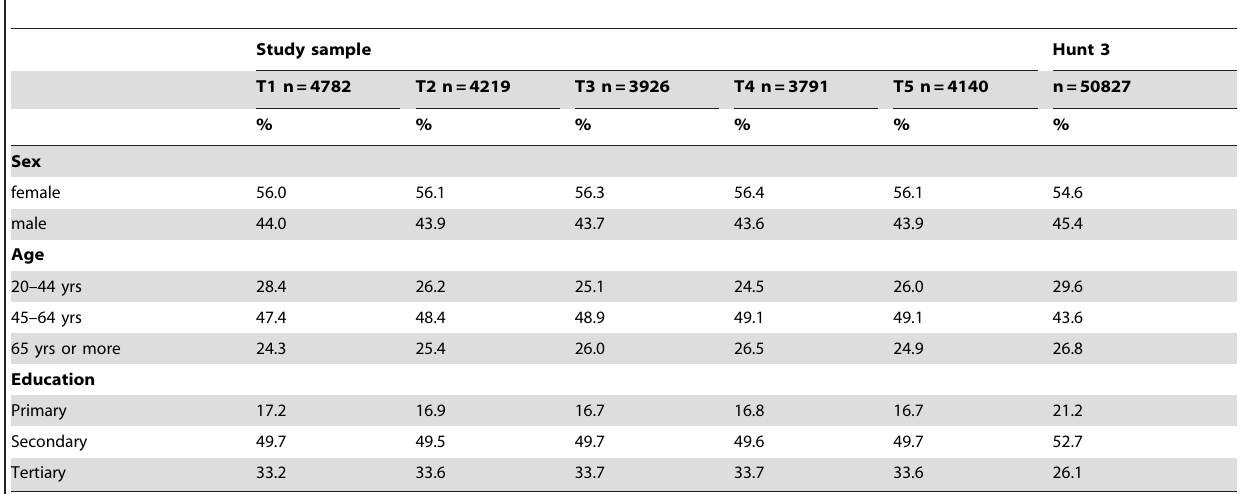
Table 1. Characteristics of the study sample at each follow up (T1–T5) and compared to the entire HUNT 3 population.